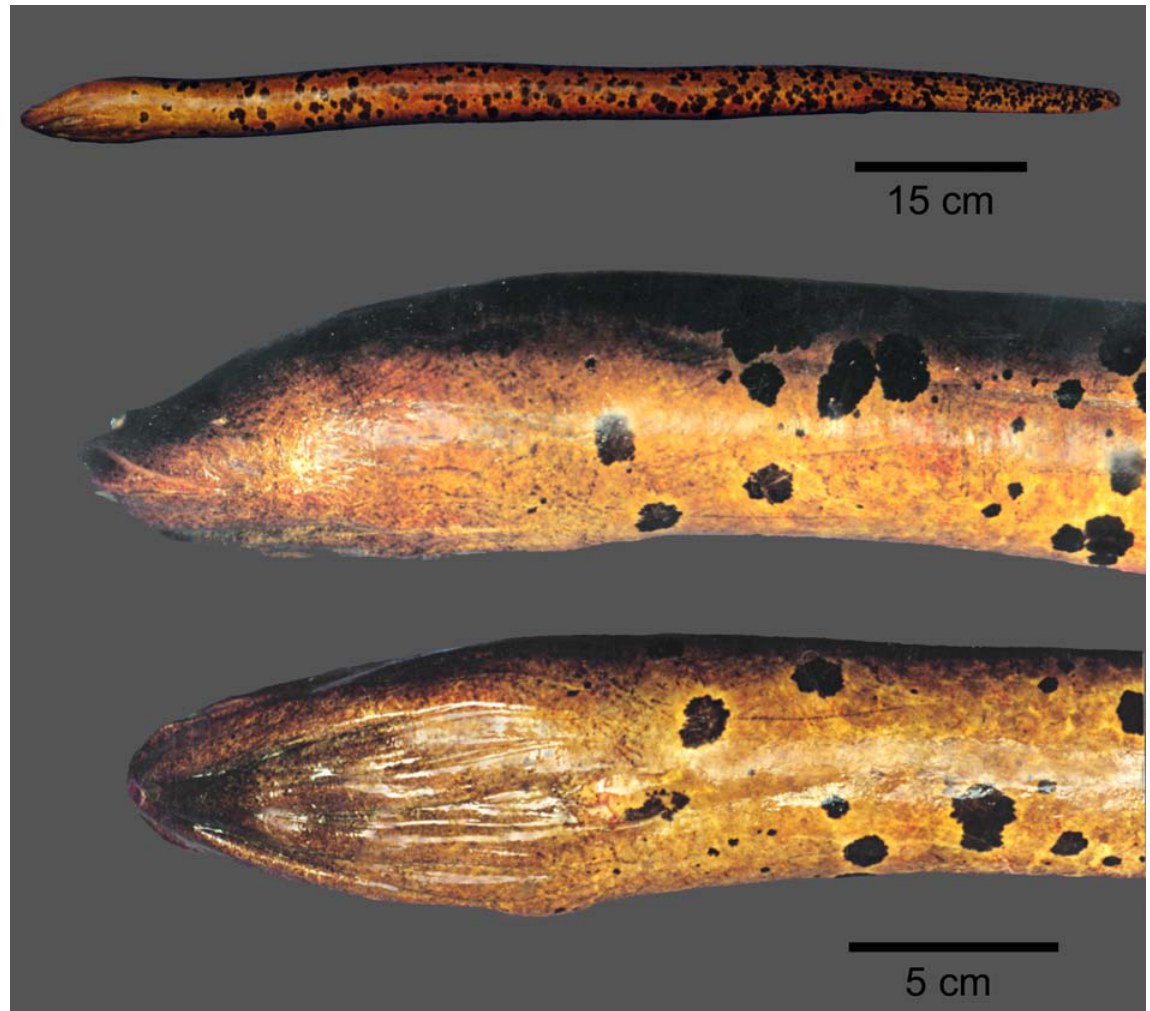
Fig. 1 . Synbranchus lampreia, holotype, MZUSP 50184, 986.0 mm TL; Brazil, Pará, ilha de Marajó, rio Goiapi. General view on top, lateral view of anterior portion of body on center, and ventral view at